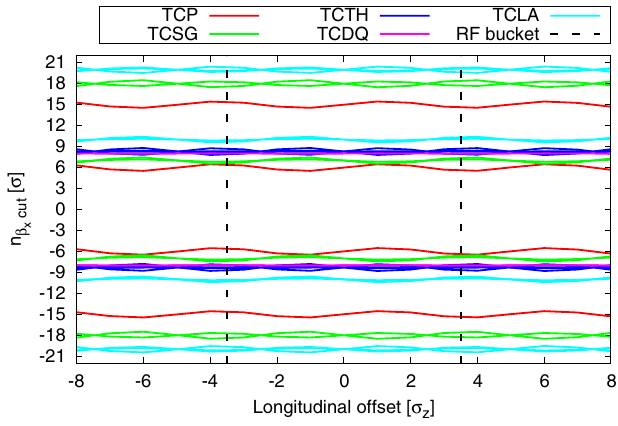
FIG. 26. (Color) Phase-space cut by various collimators in the presence of crab dispersion but zero momentum dispersion, with the hierarchy of primary (TCP), secondary (TCSG), tertiary (TCTH), beam dump (TCDQ) horizontal collimators, and shower absorbers (TCLA). D r ð i coll ; (cid:8) Þ ¼ 0 in formula